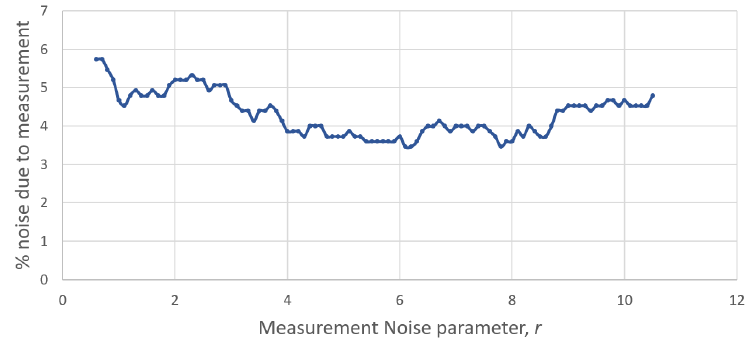
Figure 5. Variation of percentage of signal noise with measurement noise parameter r : organisation FT